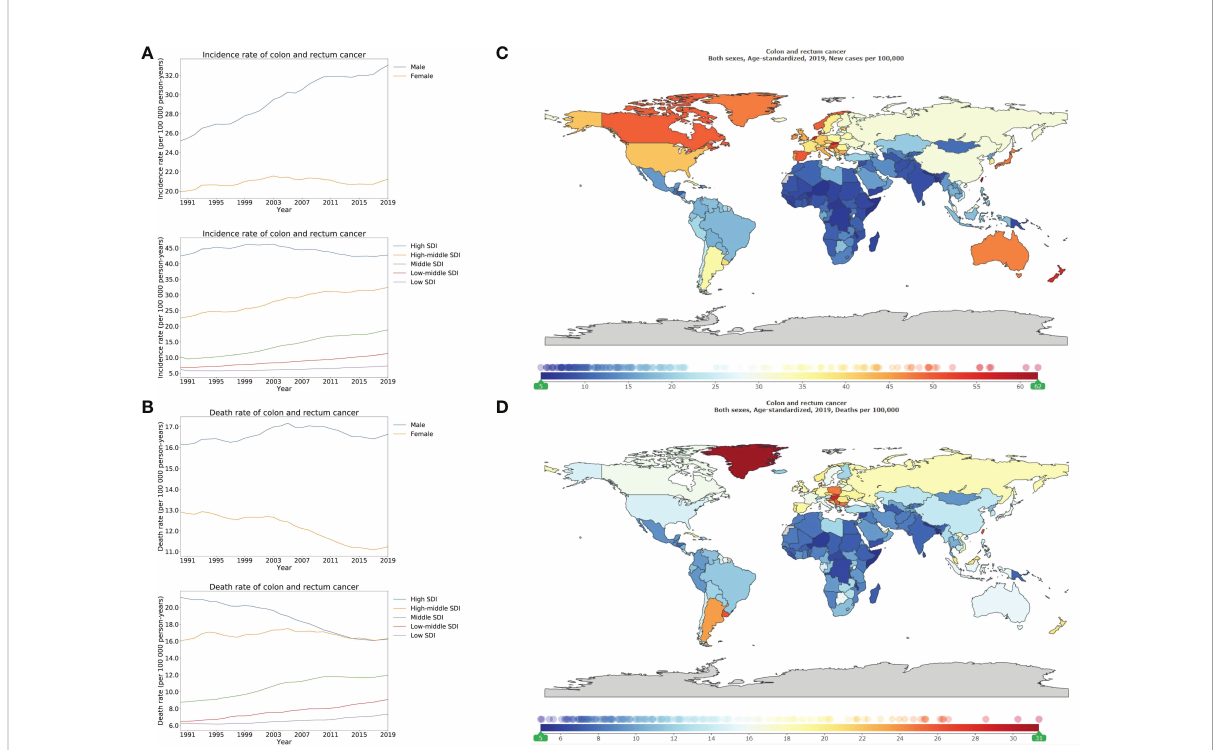
FIGURE 1 Burden of colorectal cancer for 204 countries and territories. Age-standardized incidence (A) and death (B) rate per 100000 population of colorectal cancer from 1990 through 2019 by country and territory, strati fi ed by sex or SDI; age-standardized incidence (C) and death (D) rate of colorectal cancer per 100000 person-years by country and territory, in 2019. The maps in (C) and (D) were generated by GBD 2019